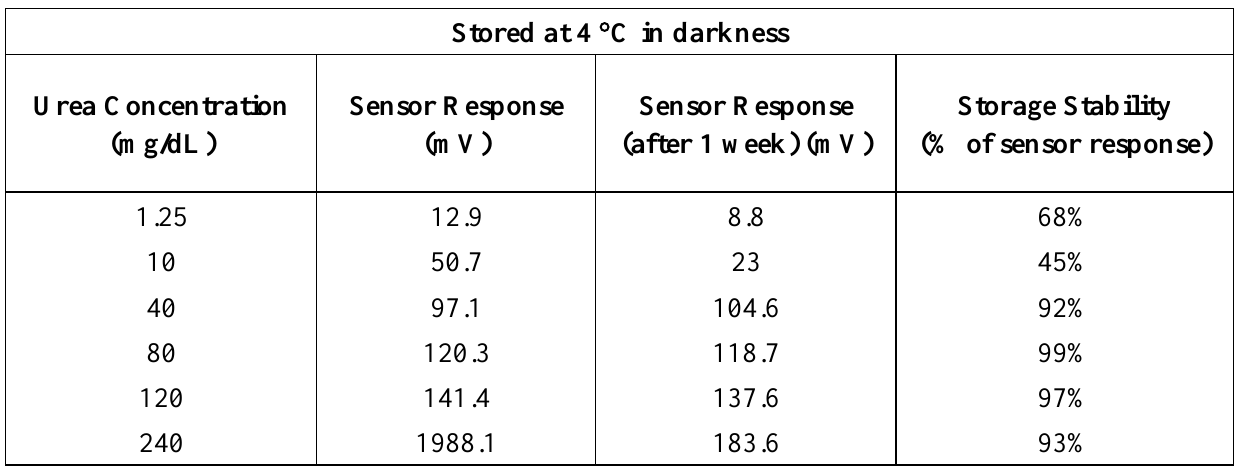
Table 2. The storage and repeatability performances of